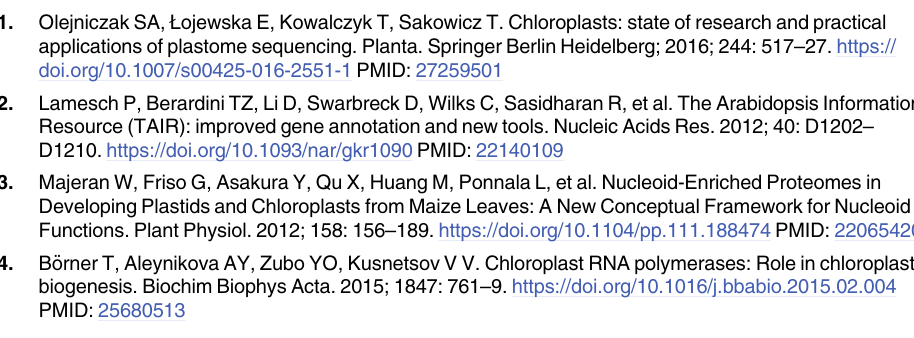
ciprofloxacin (EST+CIP). PCR results shown are representative of at least three independent experiments. Low cycle amplification of the atpB plastid gene was used as a loading control. Primer pairs used for each PCR reaction are shown next to the gels. Arrows and numbers on the right side of the gels represent the position and size of the DNA ladder bands in kilobases. (B) The bar graphs represent the fold change intensity (mean + standard error) of the PCR bands in A for each plant line with respect to Ctl_A grown on EST. Two-tailed paired t-test, (ns: not-significant, � : p <